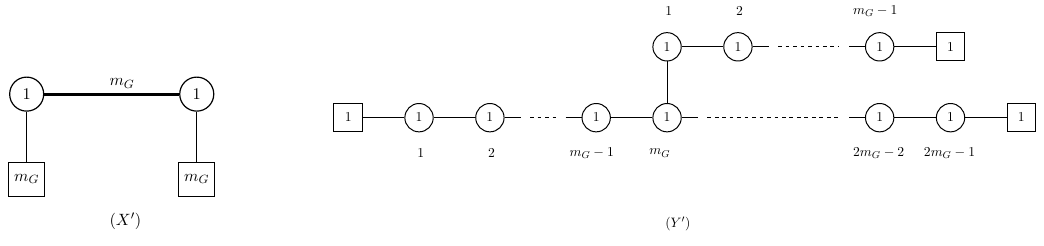
Figure 6 . The quiver X 0 is the 3d mirror of ( A p − N − 1 , A N − 1 ) (with m = 3 and m G arbitrary) reduced on a circle, constructed from the class S prescription. The quiver Y 0 is the 3d mirror of X 0 , i.e. a Lagrangian realization of the SCFT obtained by the reduction of ( A p − N − 1 , A N − 1 ) (with m = 2 and m G arbitrary) on a circle.